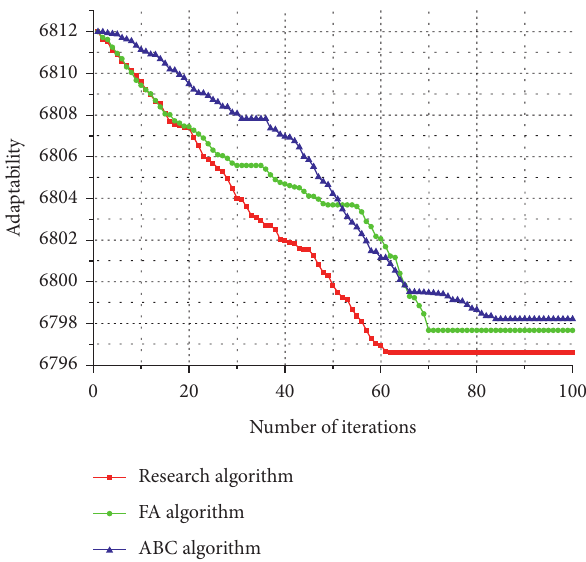
Figure 6: Convergence curves of segmentation methods.